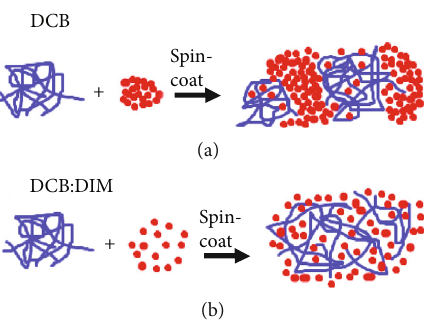
Figure 13: Schematic of PCDTBT and PC DCB and (b) DCB:DIM and the resulting fi lm morphology.